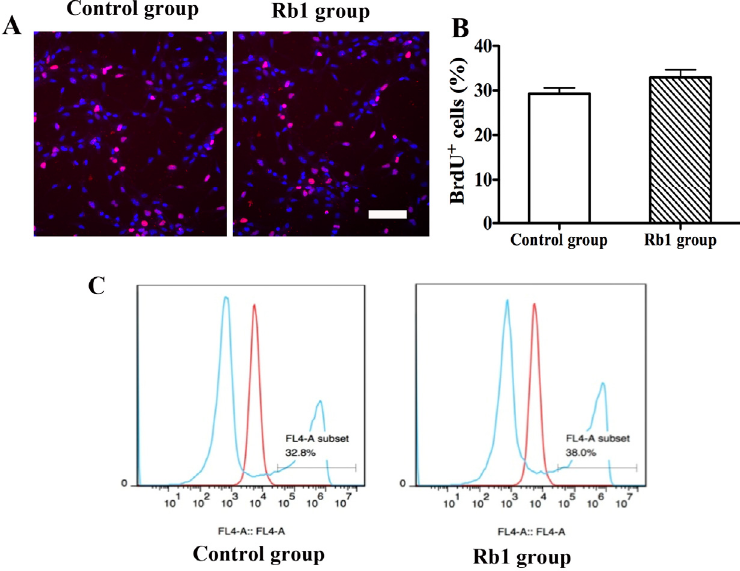
Figure 4. Effects of Rb1 on NPCs proliferation. ( A ) Representative photomicrographs of BrdU staining; ( B ) There was no difference in the percentage of BrdU-positive cells between the Rb1 group and control group. Eight representative fields per well and three wells per experiment were counted. Data were presented as means ± SEM from six experiments; ( C ) Flow cytometry analysis demonstrated that there was no difference in the percentage of proliferative cells between the Rb1 group and control group. Scale bar: 40 µm.